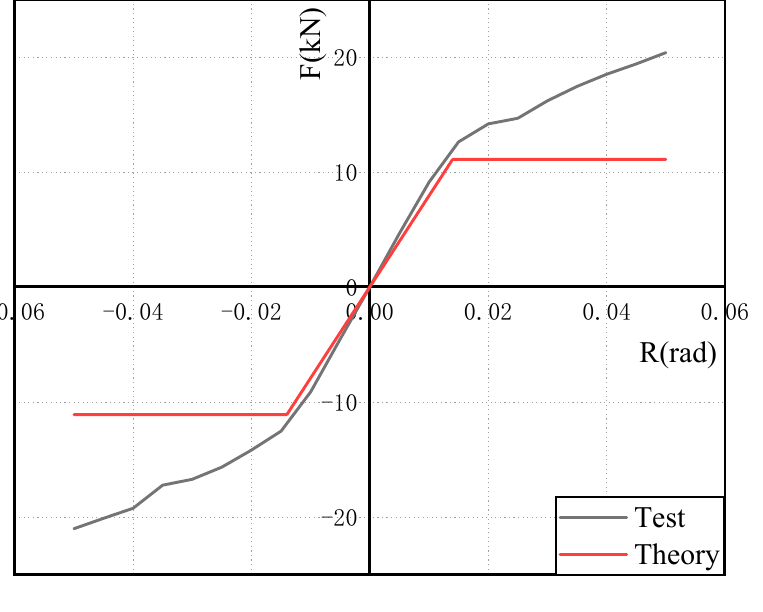
Figure 11. Skeleton curve. Table 3. Inaccuracy analysis.